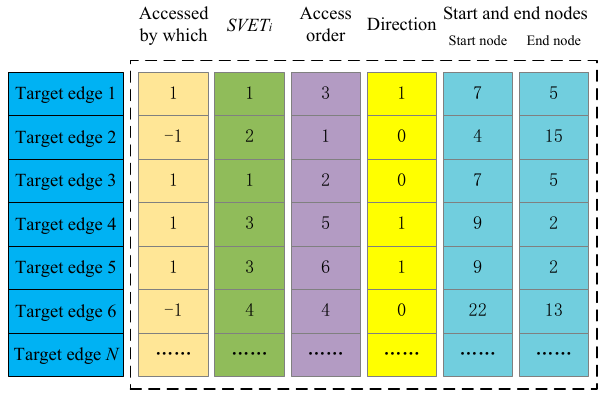
Figure 3. Encoding of matrix variable 𝐴 .